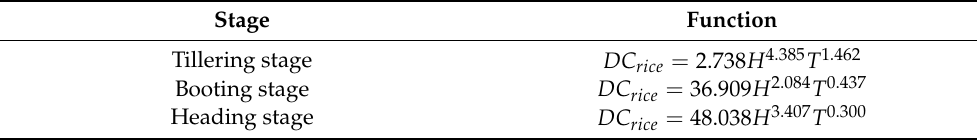
Table 1. Crop waterlogging production function of rice in Jiangsu Province,